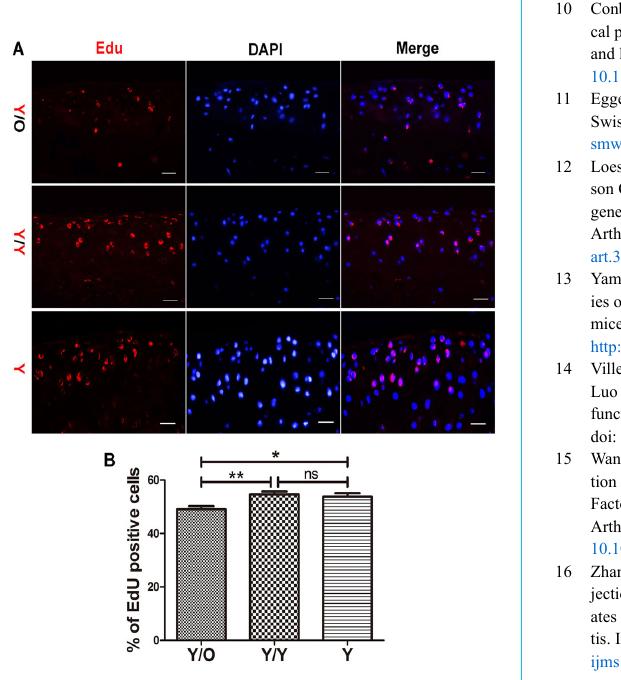
Figure 5: Young mice in the Y/O group displayed a lower percent- age of EdU-positive chondrocytes. (A) Chondrocyte proliferation decreased in the Y/O group. Pictures are shown with 400 × magni- fication. Scale bar = 200 μm. (B) The young mice in the Y/O group had significantly lower rates of chondrocyte proliferation compared to the two other control groups (8 mice per group). One-way ANO- VA with Tukey’s post-hoc test was used to assess the difference of the percentage of EdU-positive chondrocytes among three groups.* p <0.05, ** p <0.01. Values are presented as mean ± standard error of the mean. EdU = 5-ethynyl-2′-deoxyuridine; O